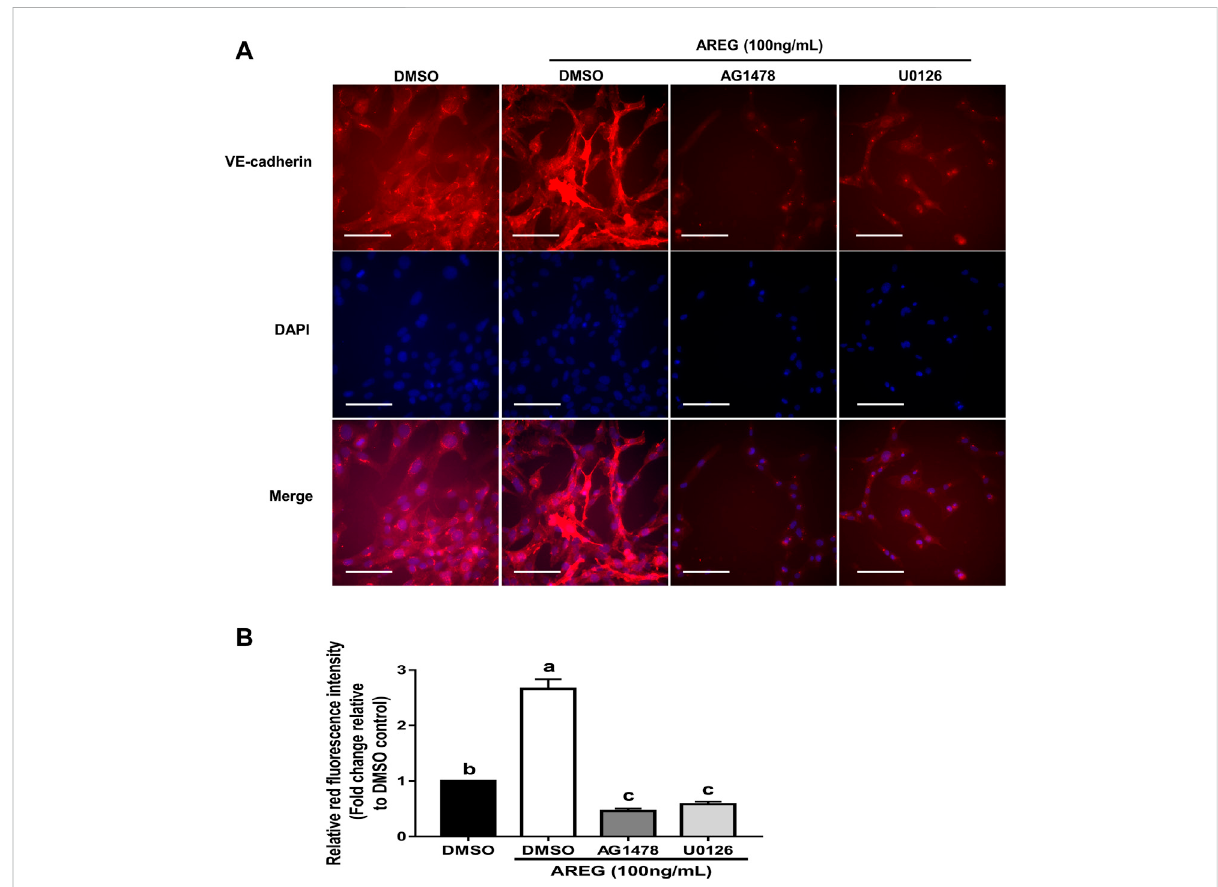
FIGURE 5 Fluorescence intensity assay showing the effects of the inhibitors AG1478 and U0126 on the AREG-induced upregulation of VE-cadherin in SVOG cells. (A) Cells were pretreated with DMSO, 10 µM AG1478 or 10 µM U0126 for 1 h and then treated for further 24 h with or without AREG (100 ng/ml).TheVE-cadherinlevelsweredeterminedusingimmuno fl uorescentstaining (B) ,andthe fl uorescenceintensitywasfurtherquanti fi edby ImageJ. Scale bars represent 100 µm. Values labeled with different letters are signi fi cantly different ( p < 0.05), n = 3.